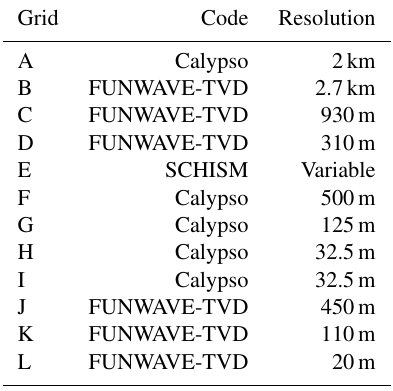
Table 2. Summary of grid characteristics (see Fig. 4 for footprints of grids A, B, C, D and E and Fig. 5 for footprints of grids F, G, H, I, J, K and